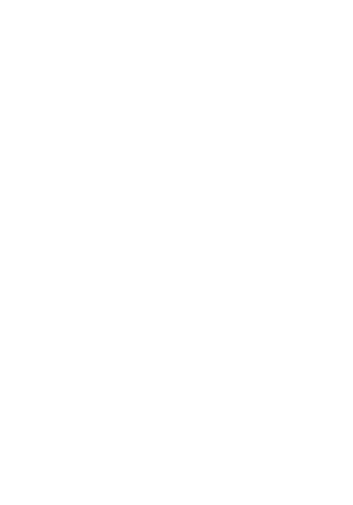
Fig 3. Distribution of the electrodes that are analyzed on the motor